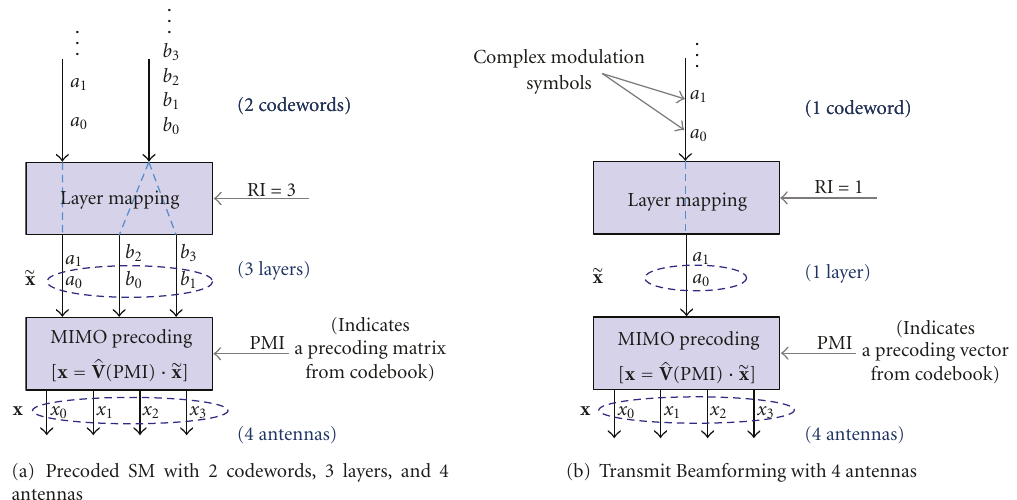
Figure 4: Transmit MIMO processing with di ff erent configurations for (a) precoded spatial multiplexing and (b) Transmit beamforming.